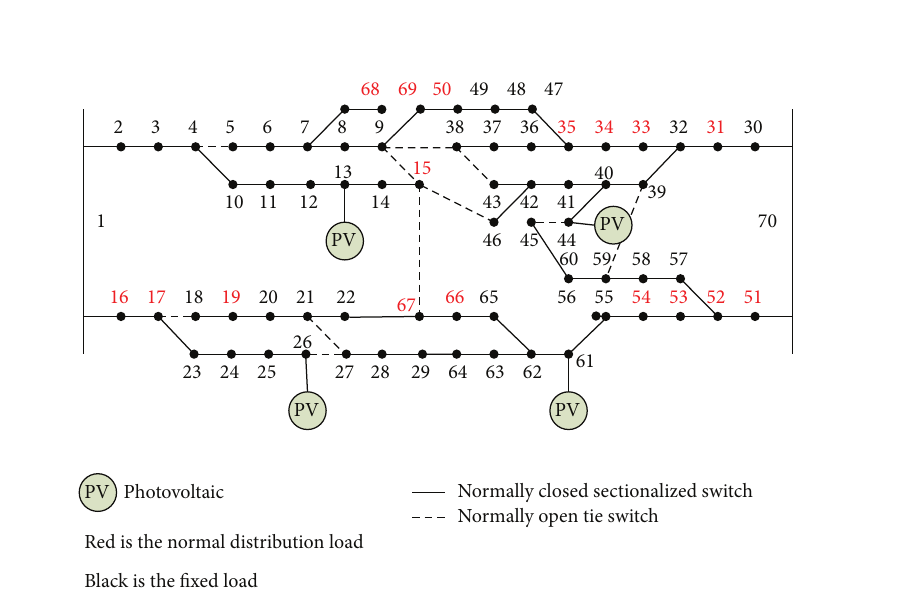
Figure 1: One-line diagram for the 70-bus distribution